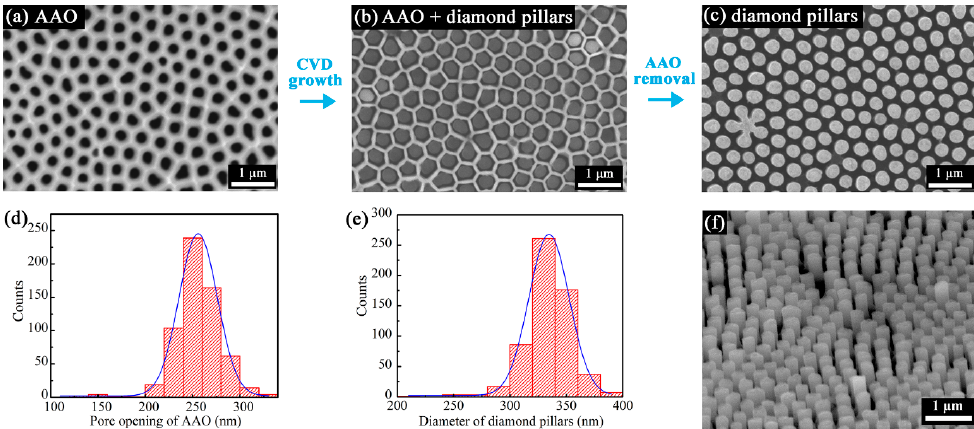
Figure 2. Characterization of AAO membrane and as-grown diamond pillars with nominal diameter of ~300 nm. Top-view SEM images of ( a ) AAO membrane, ( b ) diamond pillars within AAO membrane, and ( c ) released diamond pillars without AAO (note: images not from same location). Frequency distribution histograms of ( d ) AAO nanopores and ( e ) diamond nanopillars as derived from multiple SEM images. ( f ) SEM image of tilted surface (approximately 30°) of released diamond pillars.